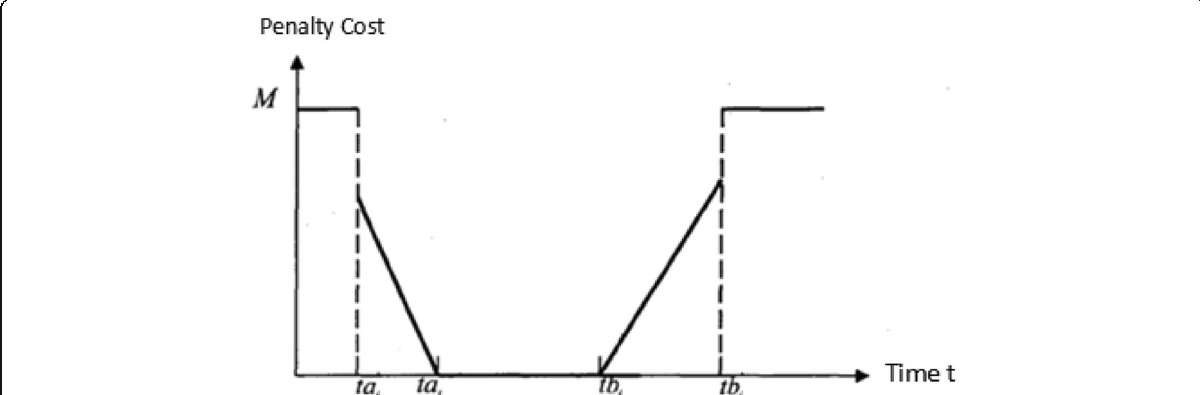
Fig. 6 Soft time window indication. Vehicle Routing Problems with Time Window (VRPTW) is an extension of the general vehicle routing problem. Its goal is to minimize the sum of vehicle travel time and waiting time when providing service to customers in the time window. According to the time constraint or not, it can be divided into two categories: soft time window (VRP) and hard time window (VRP). The soft time window VRP requires that access be reached within the time window as much as possible; otherwise, a certain penalty will be given, that is, when the vehicle arrives at the earliest arrival time, the cost of the loss is the penalty when the vehicle arrives at the latest arrival time, while the hard time window VRP requires that the vehicle must arrive within the time window; otherwise, the service will be